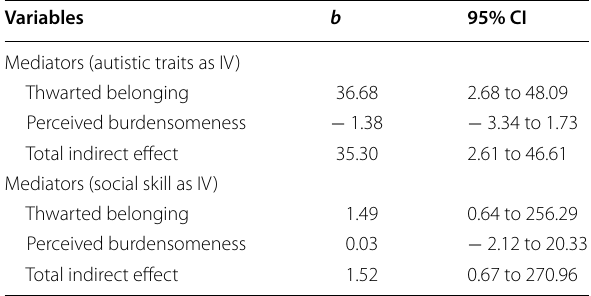
Table 3 The indirect effect of mediators in two mediation models on the recurrence of self-harm as the dichotomous dependent